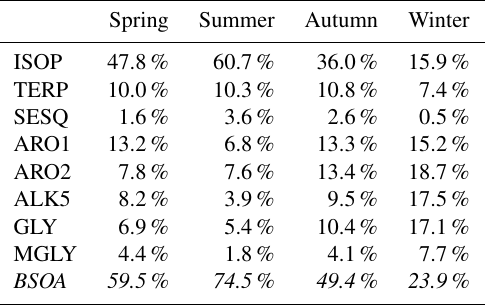
Table 3. Predicted seasonal average precursor contributions (%) to SOA. ISOP: isoprene; TERP: monoterpenes; SESQ: sesquiterpenes; ARO1 and ARO2: aromatic compounds; ALK5: long-chain alkanes; GLY: primary glyoxal; MGLY: primary methylglyoxal; and BSOA: SOA due to biogenic emissions (ISOP + TERP + SESQ; in italic).